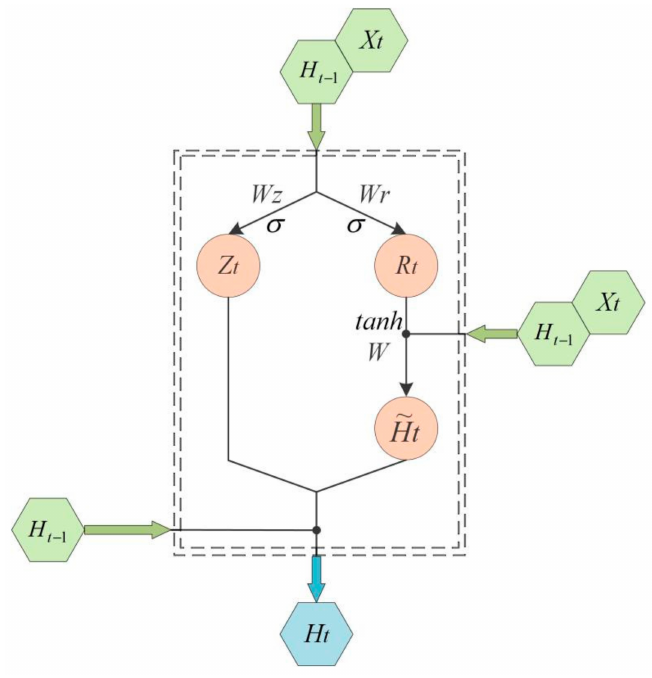
Figure 2. The structure of the neuron in the gated recurrent unit